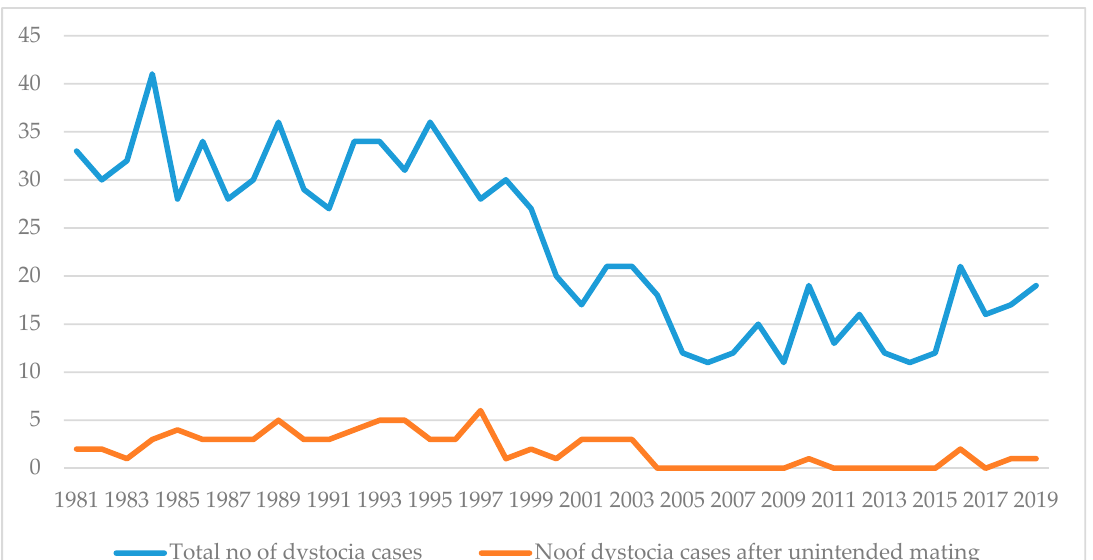
Figure 1. The occurrence of dystocia after unintended mating in the investigated years 1981–2019.